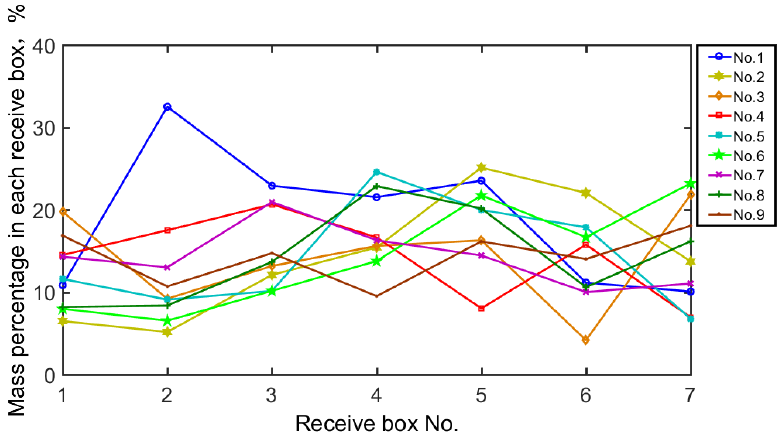
Figure 10. Distribution of grain loss in each box along the traverse direction.